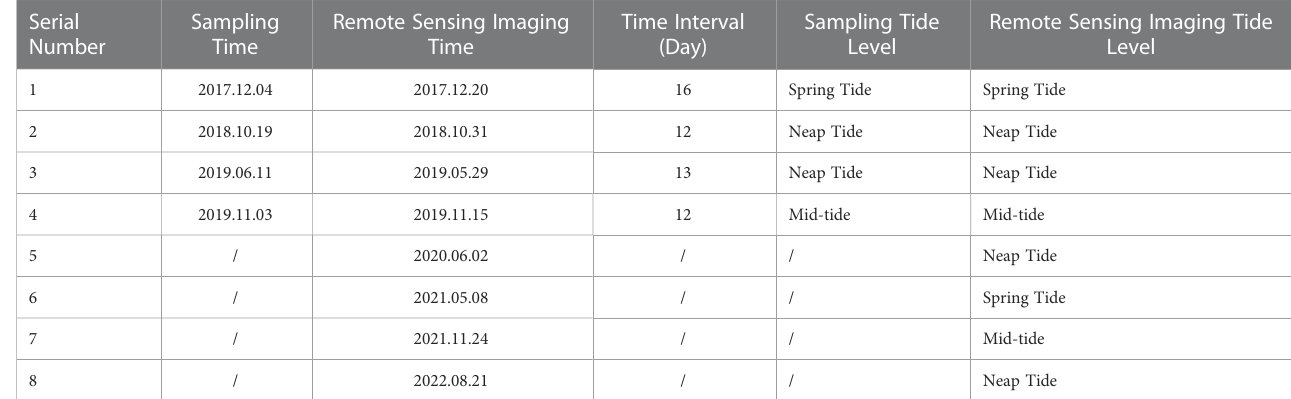
TABLE 1 Sediment sampling and remote sensing imaging